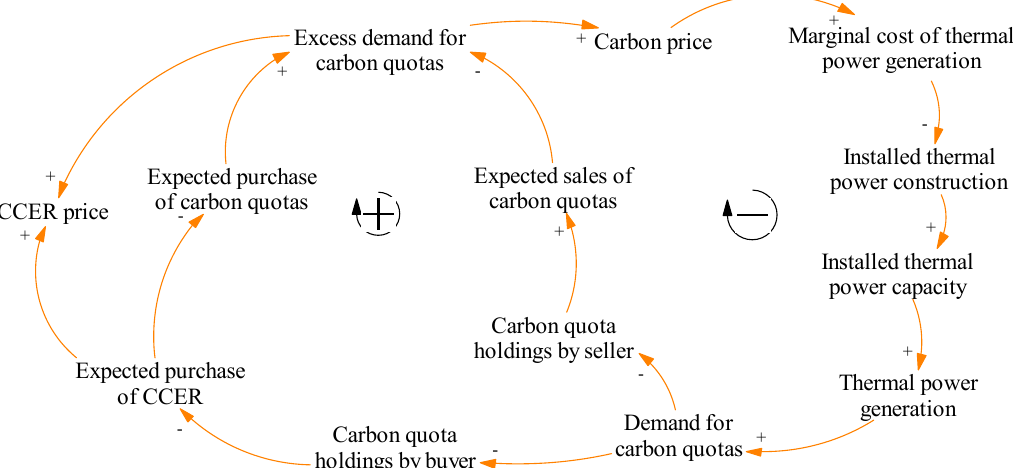
Figure 4. Causal cycle diagram of carbon trading market.